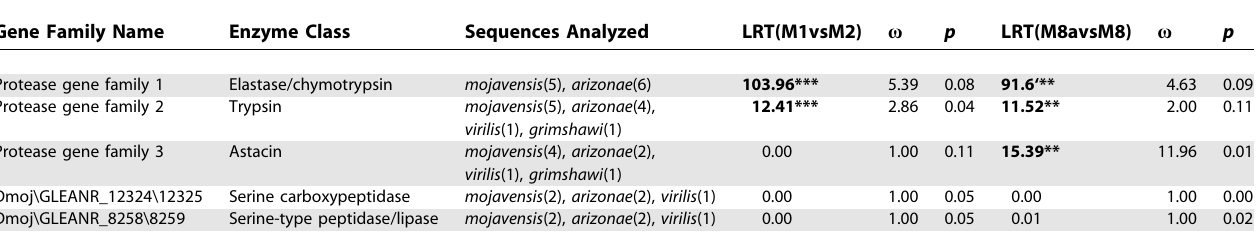
Table 2. PAML Analysis of Positive Selection in Duplicated Proteases